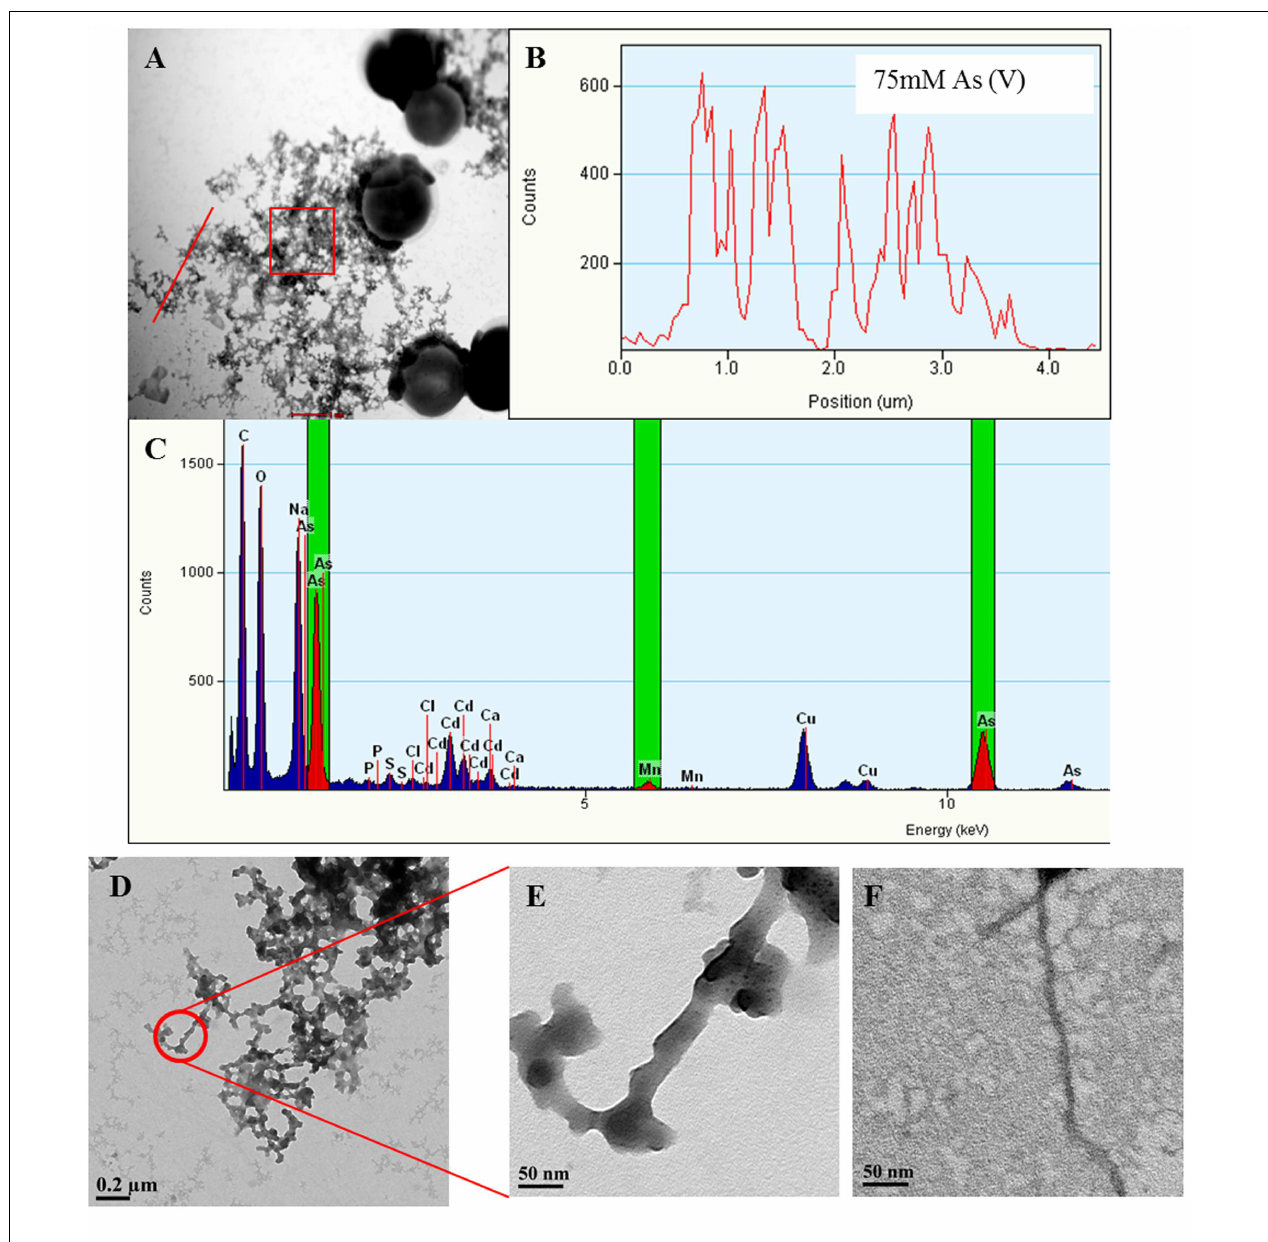
FIGURE 5 | Arsenic binds to Synechocystis TFP. Representative images showing Synechocystis cells treated with 75 mM As (V) (A) . Line EDX spectra (B) and EDX of square area (C) (highlighted by red color in A ) confirms the presence of As on putative TFP-As complexes. EDX spectrum (C) also shows small Mn peaks suggesting its possible presence on putative TFP. Line EDX data was collected from left to right direction (i.e., from bottom to top) image (D,E) are the high magnification images of putative TFP-As complexes ( ≥ 15 nm diameter). TFP from control cells (5–7 nm in diameter; F) at same magnification (X 29000) as that of putative TFP-As complex in image (E)